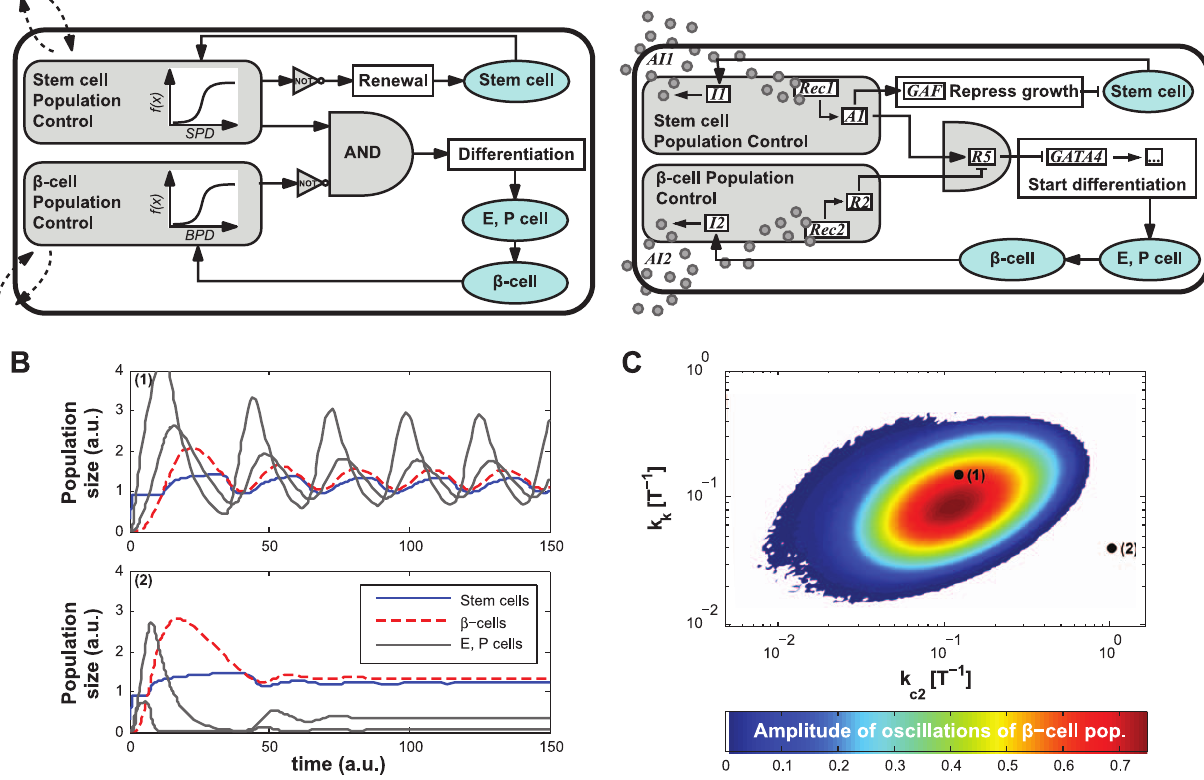
Figure 2. System 1. (A) Circuit diagram: two Population Control modules (in gray) sense the density of stem- and b -cells. The AND gate integrates the output of the modules to induce differentiation. Circles represent intercellular signaling molecules. (B) Two examples of population evolution showing sustained oscillations (point 1 in C ) and a stable steady state (point 2 in C ), with other parameters fixed (SI Sec. 2 and Figure S2). (C) A planar slice of the parameter space where population oscillations occur for System 1.